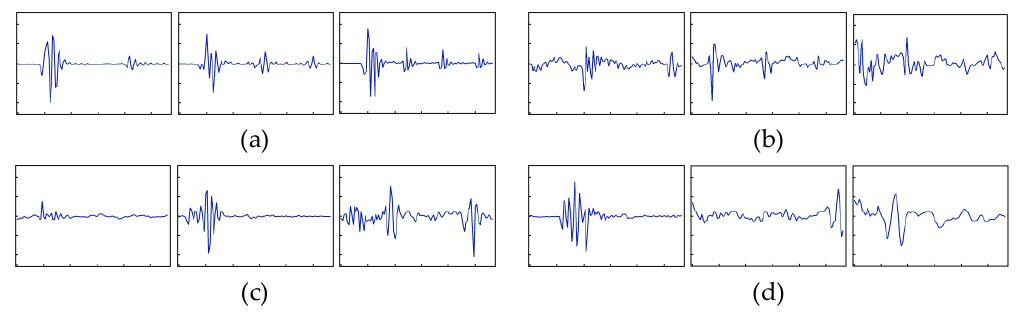
Figure 1. Actual internal detection signal. The above signals are normalized. ( a ) Ideal signals in the experimental platform. ( b ) Actual internal detection normal signal. ( c ) Abnormal signals caused by welding seams. ( d ) Abnormal signals caused by defects.